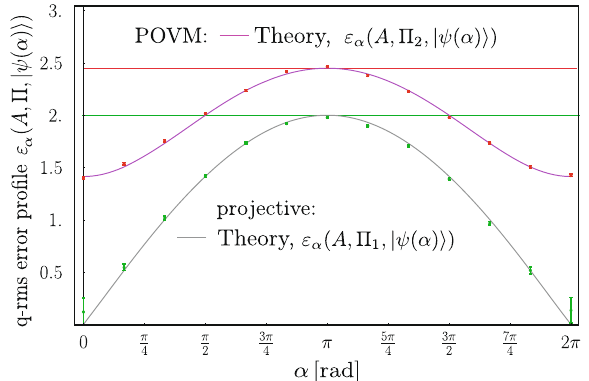
Fig. 4 Final experimental results of the q-rms error pro fi le ε α and locally uniform q-rms error ε . Green data points represent quantum root-mean-square (q-rms) error pro fi le ε α ð A ; Π 1 ; ψ ð α Þj iÞ (projective) and red data points represent ε α ð A ; Π 2 ; ψ ð α Þj iÞ (POVM), for different evolved states ψ ð α Þj i with measurement time t meas = 100 sec (error- bars represent ±1 st. dev.). Locally uniform q-rms error ε ð A ; Π 1 ; j ψ Þ ¼ ffiffiffi p 2 (projective) and ε ð A ; Π 2 ; j ψ Þ ¼ 6 (POVM) are represented by green and red line,